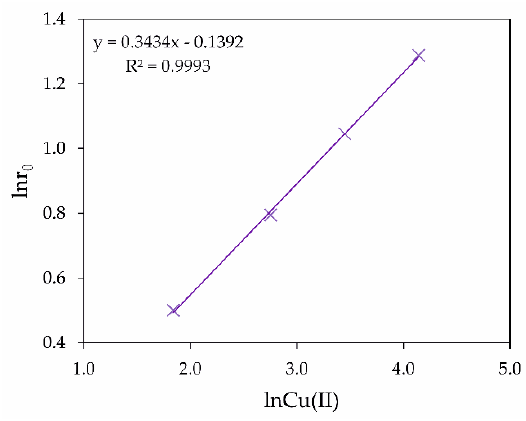
Figure 9. Lnr 0 versus lnCu (II). The experimental reaction order relative to the concentration of Cu (II) ions was 0.34 for the H 3 AsO 3 -Fe 2+ -Cu 2+ -H 2 SO 4 system (Figure 9). The positive effect of copper ions on the As (III) oxidation was associated with the catalytic effect of oxygen on the Fe (II) ions oxidation, as mentioned earlier. The reaction order relative to oxygen pressure was determined graphically (Figure